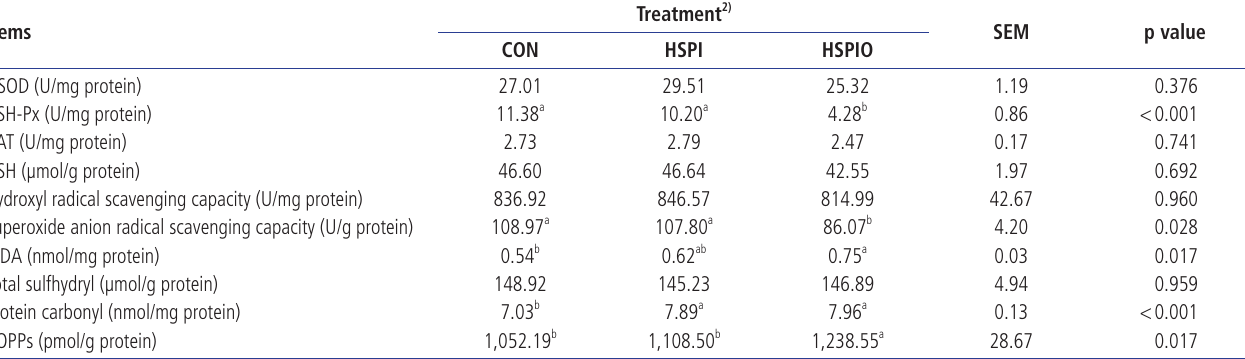
Table 8. Jejunal mucosa antioxidant indices and oxidation products content of broilers fed basal diet, heat-oxidized SPI diet or heat-oxidized mixture of SPI and 2% soybean oil diet